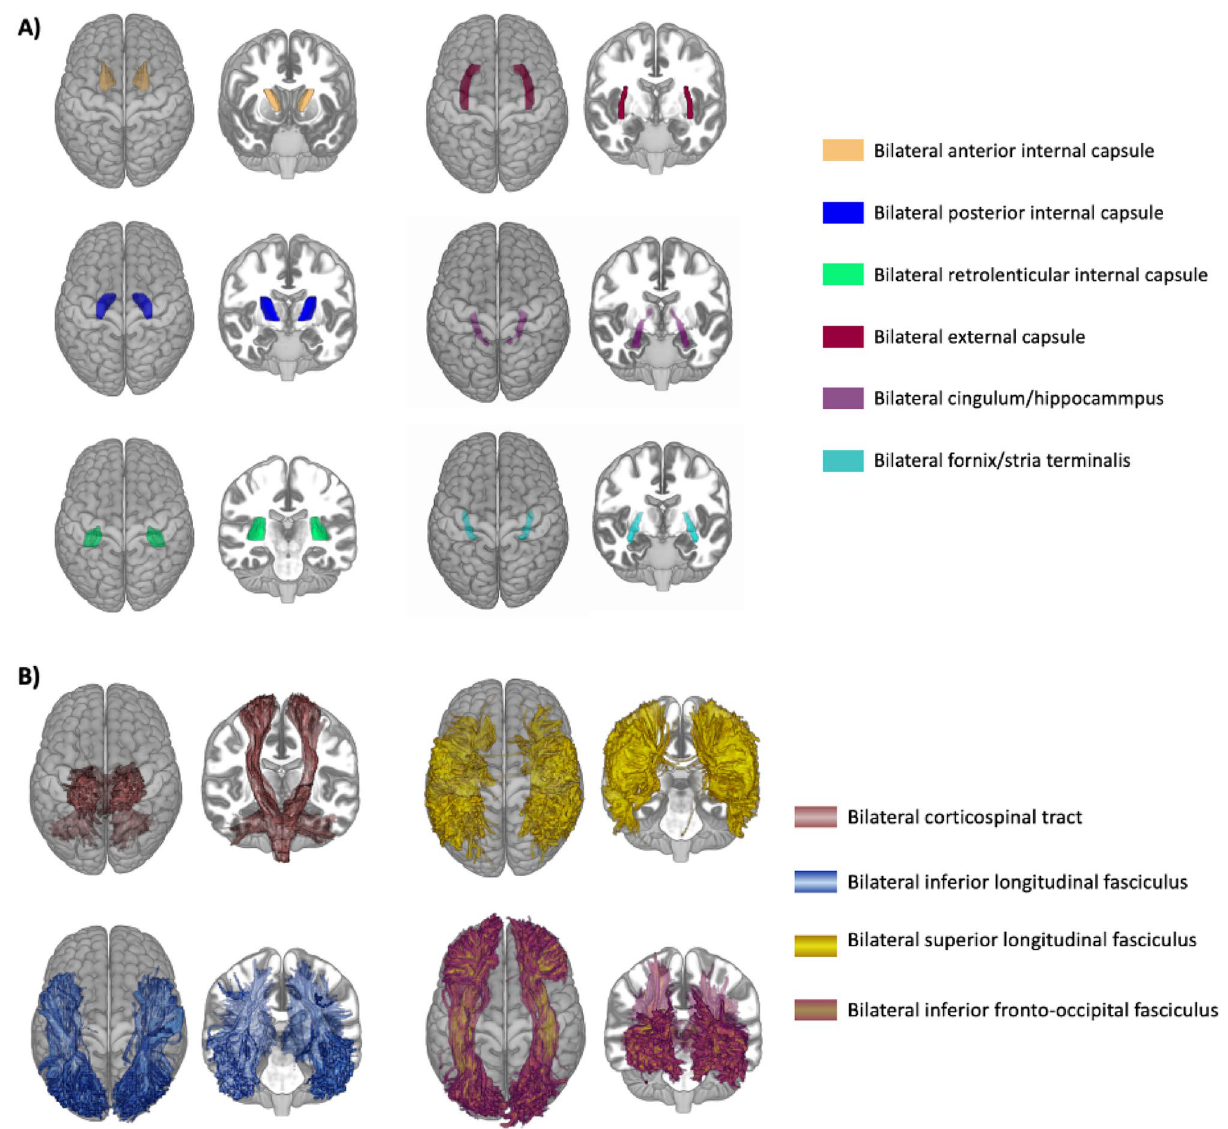
Figure 4. Graphical representation of the brain regions chosen for analysis. ( A ) Represents the chosen WM regions and ( B ) chosen tracts for the probabilistic tractography-based